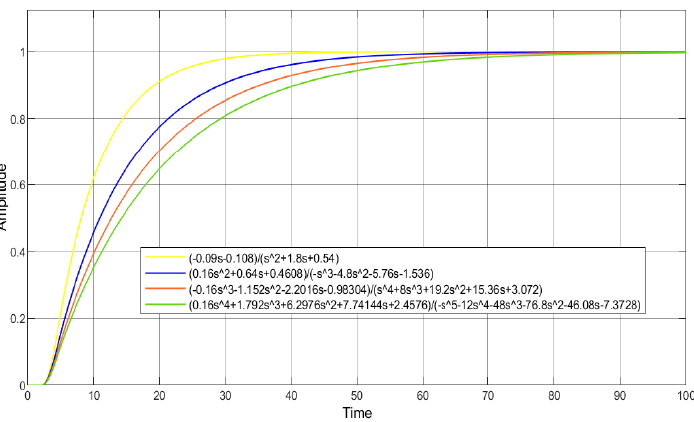
Figure 7. Simulated response of four fixed plants with a time delay using the same compensator.